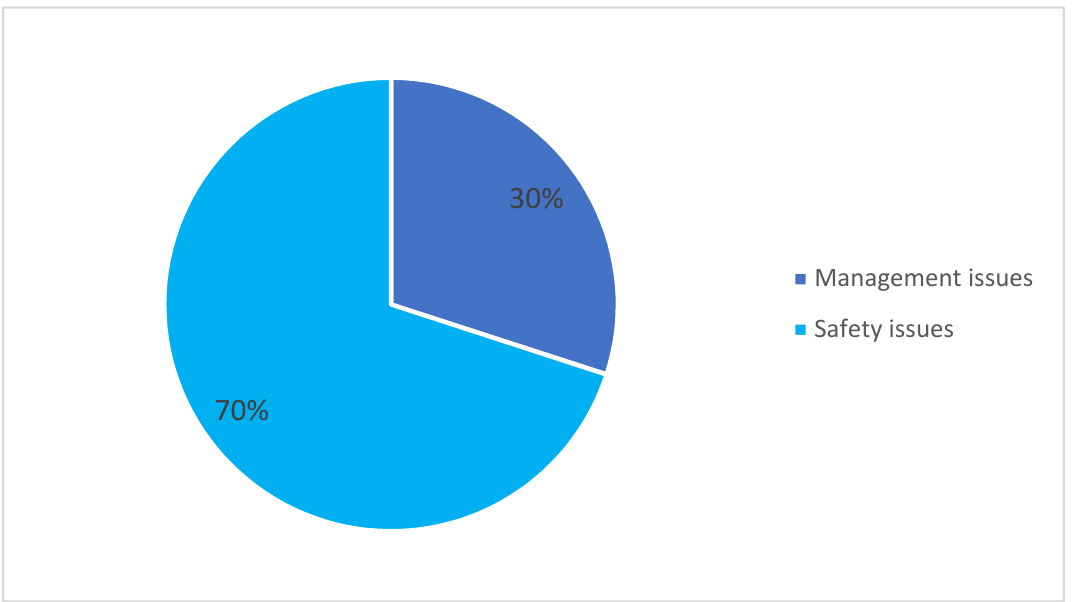
Figure 2. Areas of implementation against pandemic practices in the new mobility market.